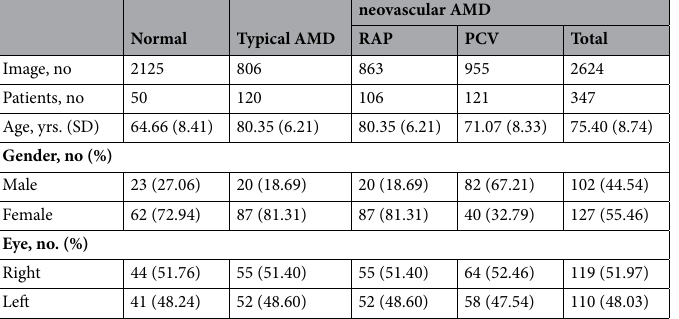
Table 1. Baseline characteristics of patients who had undergone macular OCT. OCT optical coherence tomography, neovascular AMD neovascular age-related macular degeneration, RAP retinal angiomatous proliferation, PCV polypoidal choroidal vasculopathy, SD standard deviation.